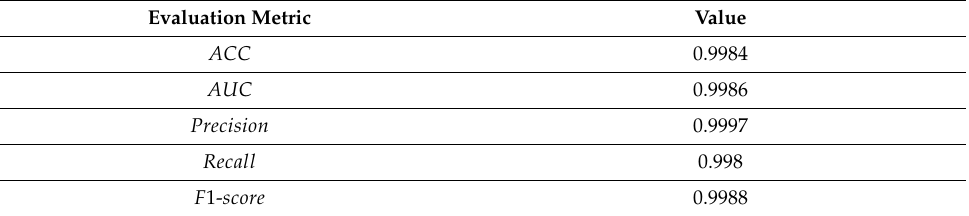
Table 8. The ACC , AUC , Precision , Recall , and F 1- score achieved with application of y 1 equation on the original dataset.